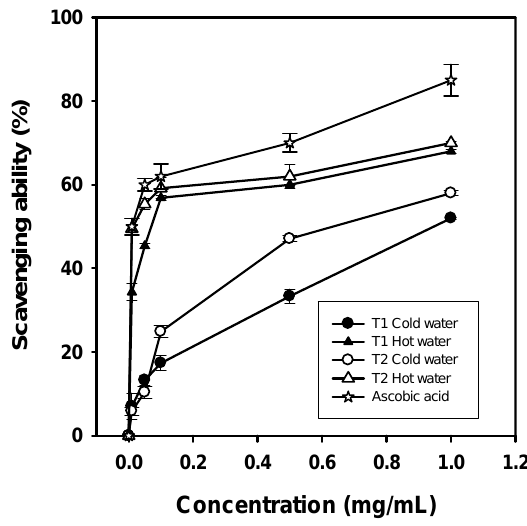
Figure 4. Scavenging ability of cold-water and hot-water extracts from G. frondosa T1 and T2 on superoxide radicals. Each value is expressed as mean ± S.D. (n =